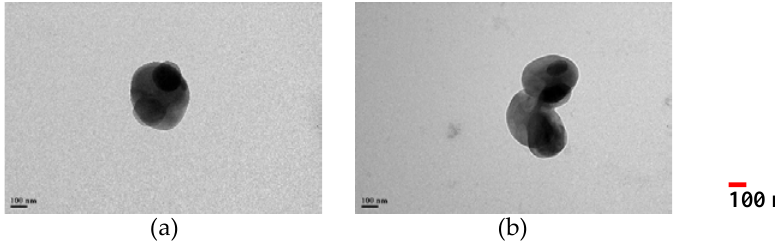
Figure 1. SEM cross-section images of PESu/h-BN composites with different compositions: ( a ) 100/0; ( b ) 99/1; and ( c ) 97/3.